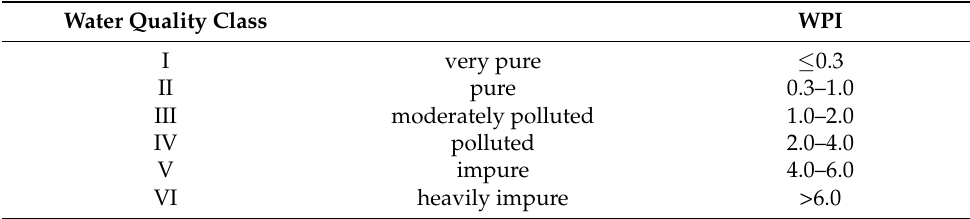
Table 1. Water quality classification based on the water pollution index